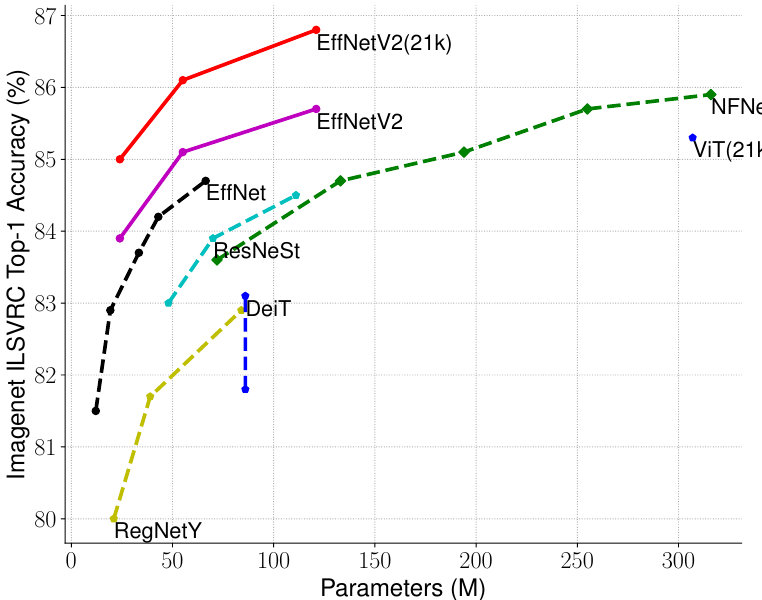
Figure 9. Model size plotted against Imagenet accuracy showing improved parameter efficiency